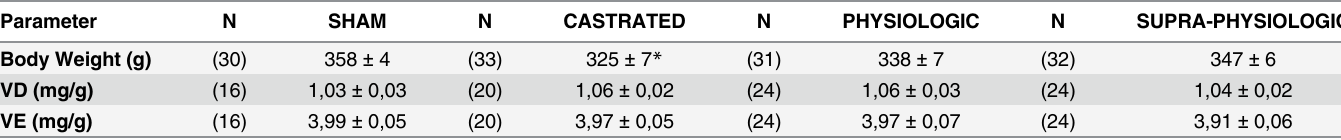
The values are expressed as the mean ± SEM.